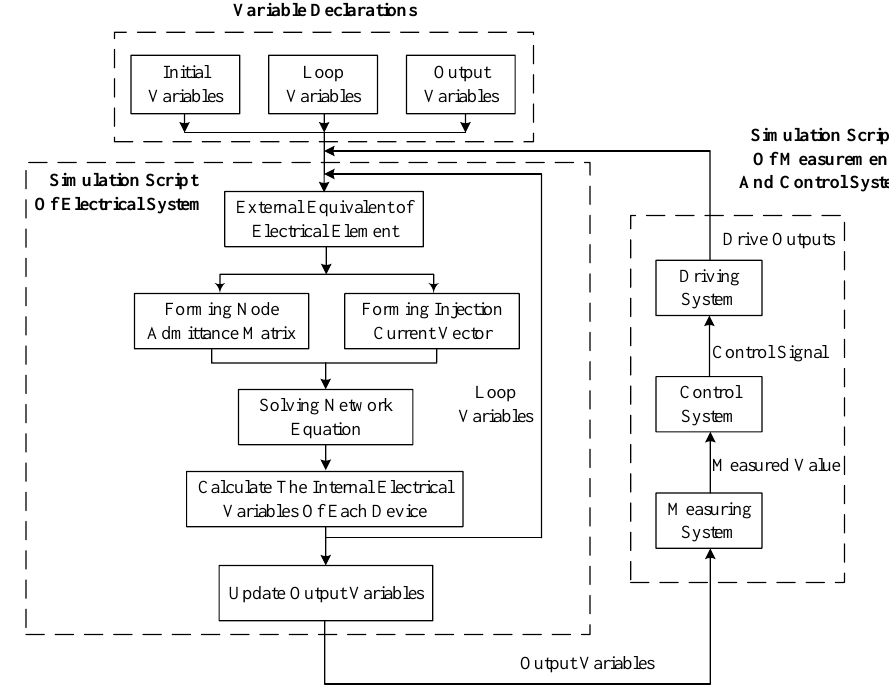
Figure 2. Specific content of the simulation